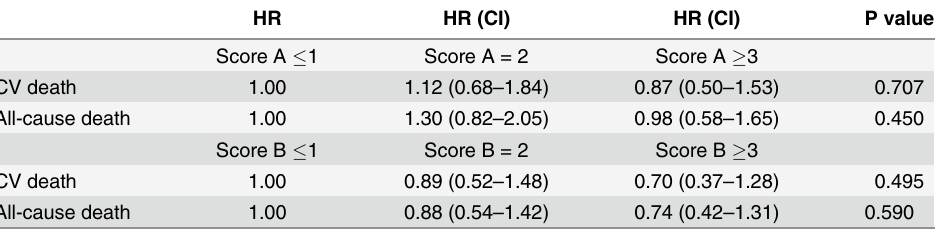
Table 5. Risk of cardiovascular (CV) death and all-cause death with genetic scores A and B in patients without angiotensin-converting enzyme inhibitor treatment after 10 years of follow-up.